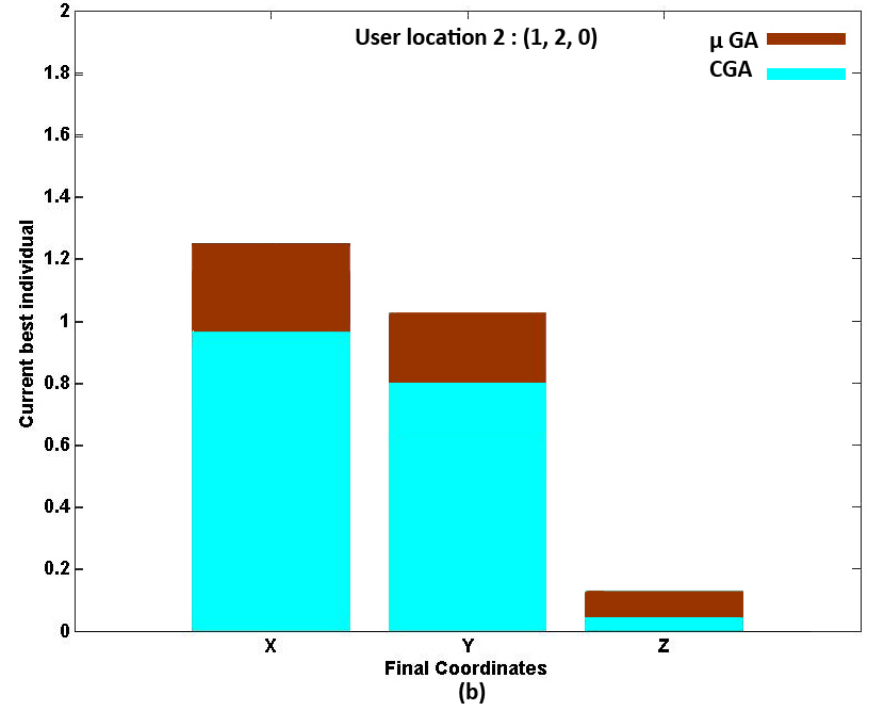
Figure 14. RX Location 2, (1,2,0): ( a ) Convergence of the CGA and µ GA to the RSS max . ( b ) Final coordinates of the CGA and µ GA.